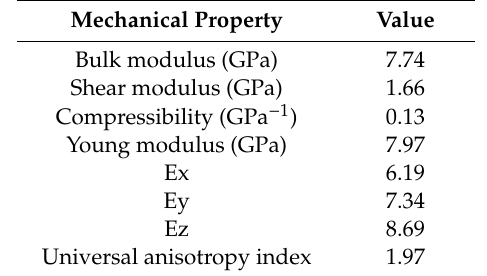
Table 9. Calculated mechanical properties of IBU.